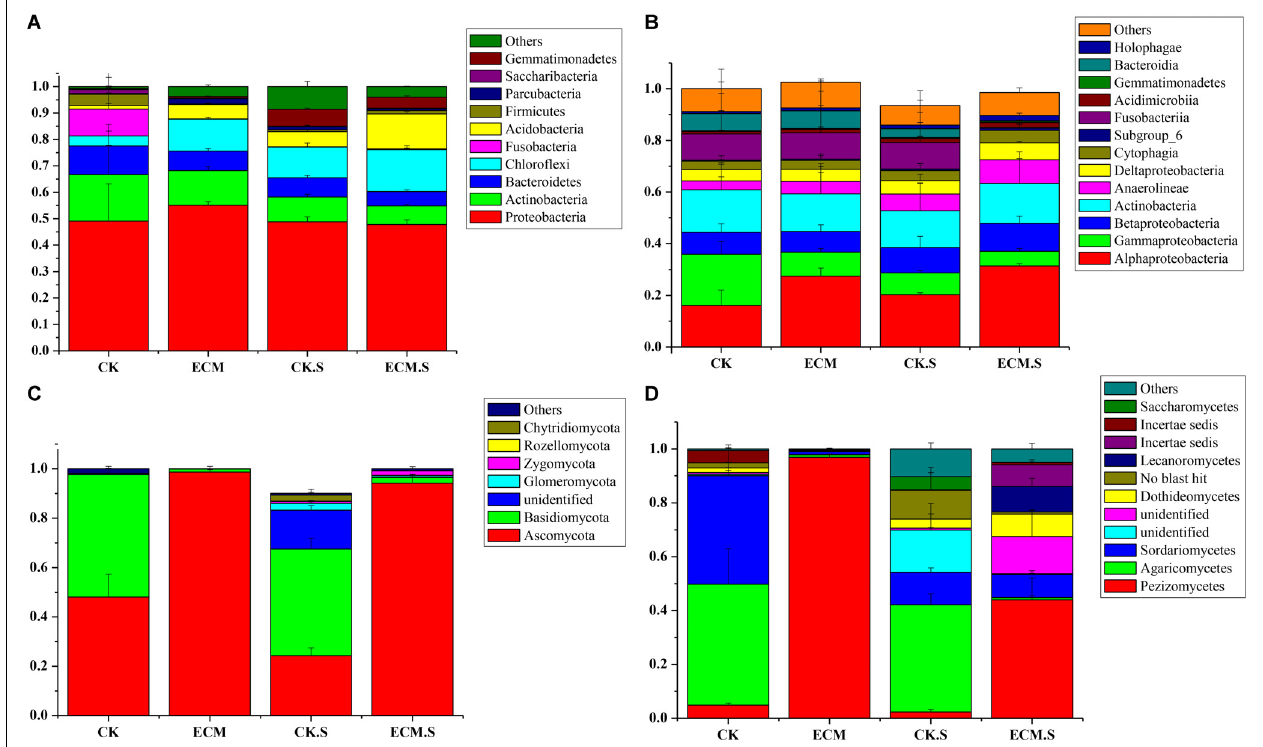
FIGURE 2 | Taxonomic composition of bacterial and fungal communities associated with Q. aliena root tips and the surrounding soil at the phylum and class levels analyzed using barcoded sequencing. ECM, ectomycorrhizae; ECM.S, ectomycorrhizosphere soil; CK, roots of Q. aliena without T. indicum partner; CK.S, rhizosphere soil of Q. aliena without T. indicum partner. (A) Bacterial phyla; (B) bacterial classes; (C) fungal phyla; (D) fungal classes. The Y axis indicated the relative abundance of each taxon. All experiments were conducted in